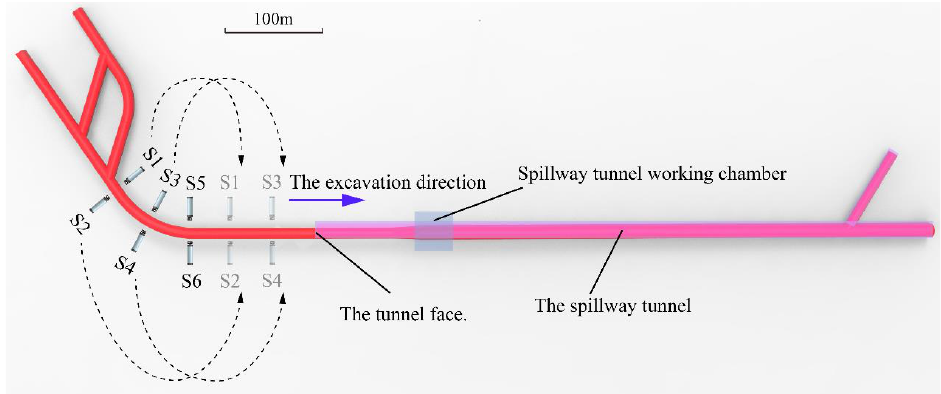
Figure 3. Schematic of sensor deployment.